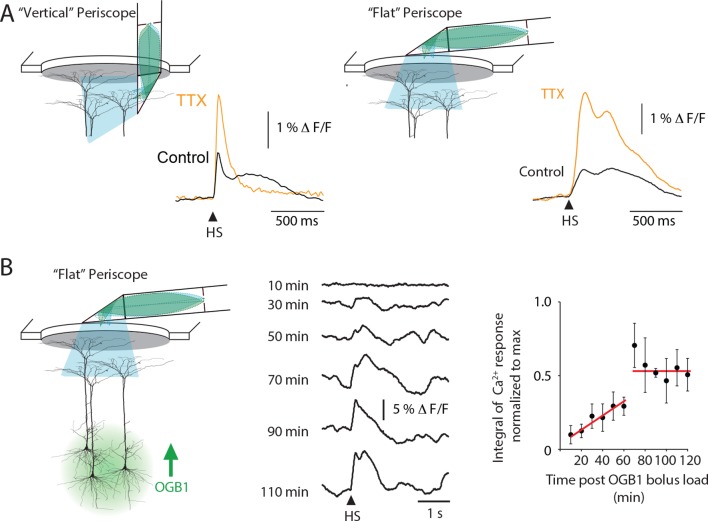
Periscope position and temporal characteristics of sensory-evoked Ca2+ responses in layer 5 pyramidal neuron dendrites.(A) Similar to the ‘vertical’ periscope, the ‘flat’ periscope recorded an increase in Ca2+ activity during TTX application into layer 5 which is caused by TTX blocking layer 5 Martinoti cells that normally inhibit sensory evoked dendritic Ca2+ influx. These results illustrate both ‘periscopes’ are able to reliably record dendritic Ca2+ dynamics. (B) A large Ca2+ response was recorded after 70min using the ‘flat’ periscope indicating the length of time required for OGB1-AM to diffuse into the dendrites of layer 5 pyramidal neurons. (left) Schematic representation of the experimental setup. The Ca2+ indicator OGB1-AM was bulk loaded into layer 5 and the fiber optic ‘flat periscope’ was positioned horizontally above the craniotomy. (middle) Ca2+ responses to hindpaw stimulation (HS) recorded 10, 30, 50, 70, 90, 110 min after OGB1-AM loading. (right) Integral of Ca2+ response normalized to the maximum at different times after OGB1-AM load. The increase over time is assumed to be due to diffusion of the indicator in the dendrites and corresponds to the time needed for stable recordings using the vertical periscope configuration.